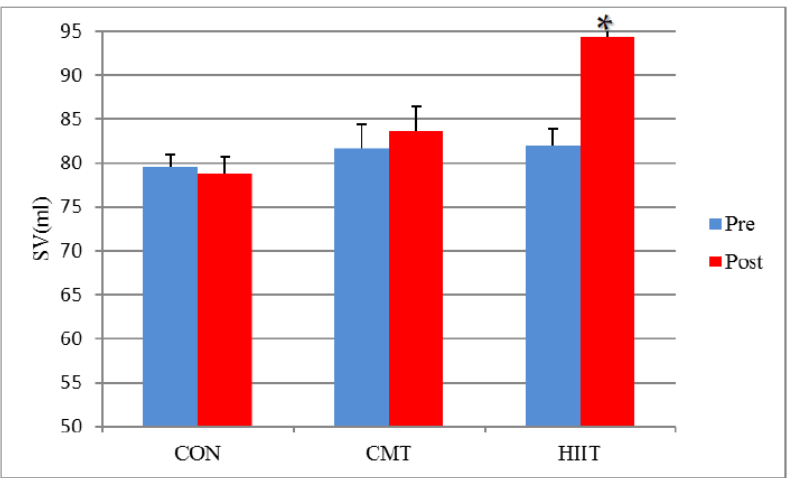
Figure 3. SV Changes before and after 12 Weeks of CMT and HIIT; * Indicates a significant increase compared with the CMT and control groups ( p < 0.05). SV: Stroke Volume (mL). CON: Control. CMT: Continuous Moderate Training. HIIT: High-Intensity Interval Training.